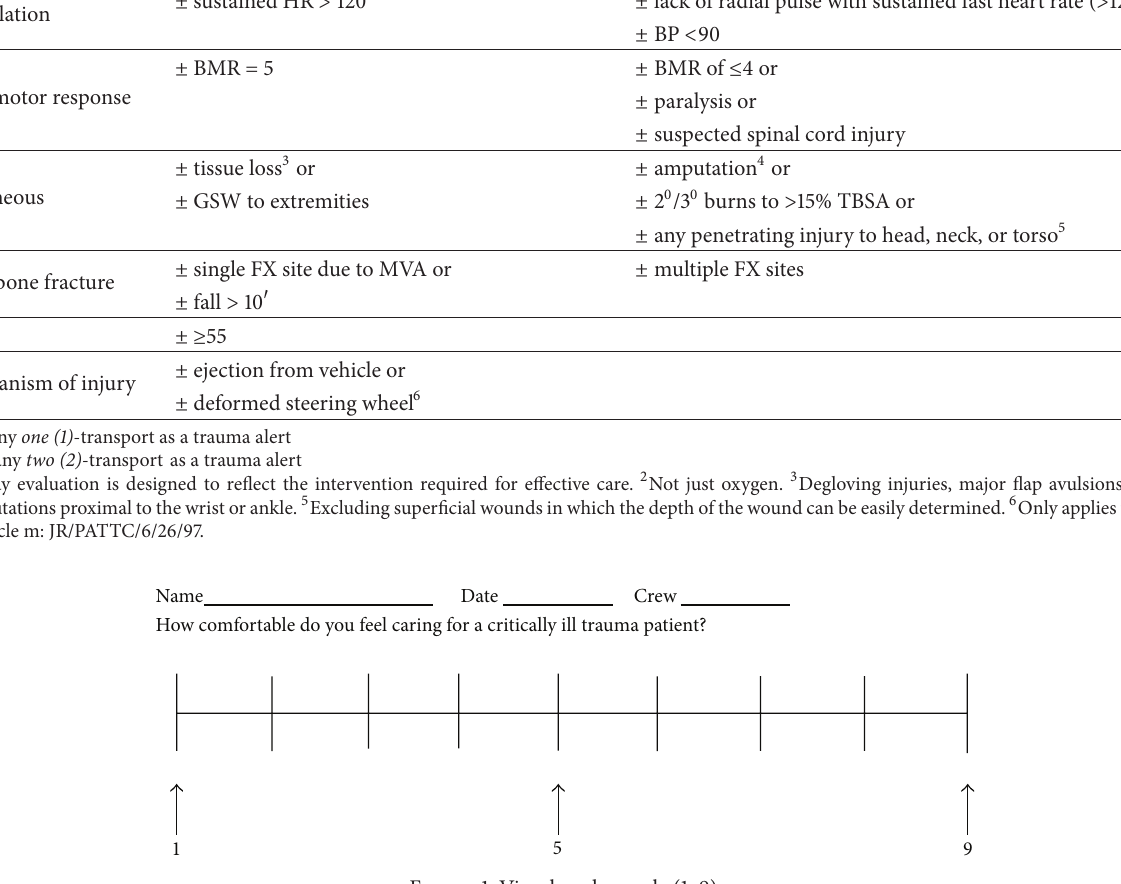
Figure 1: Visual analog scale